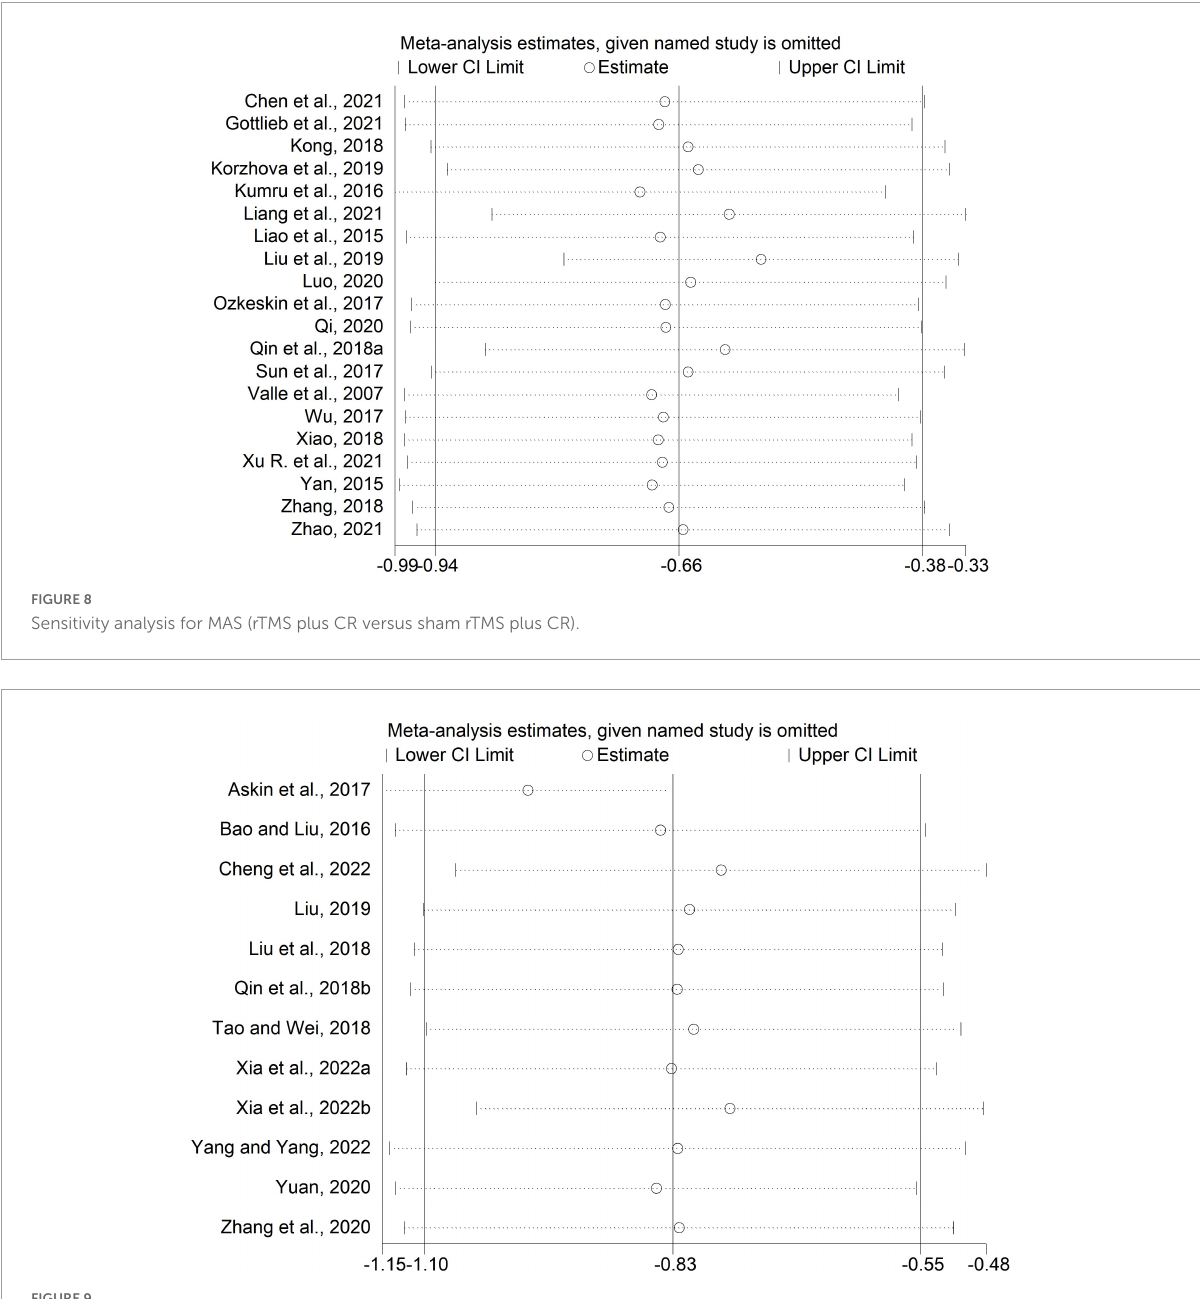
FIGURE9 Sensitivity analysis for MAS (rTMS plus CR versus